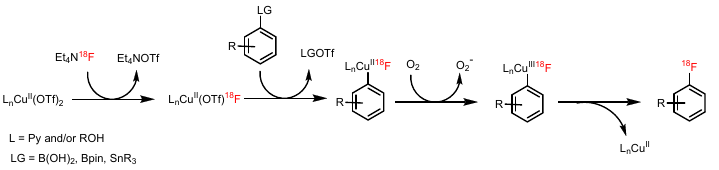
Figure 5. Proposed mechanism of Cu-mediated radiofluorination of aryl pinacol boronates, boronic acids and stannanes.